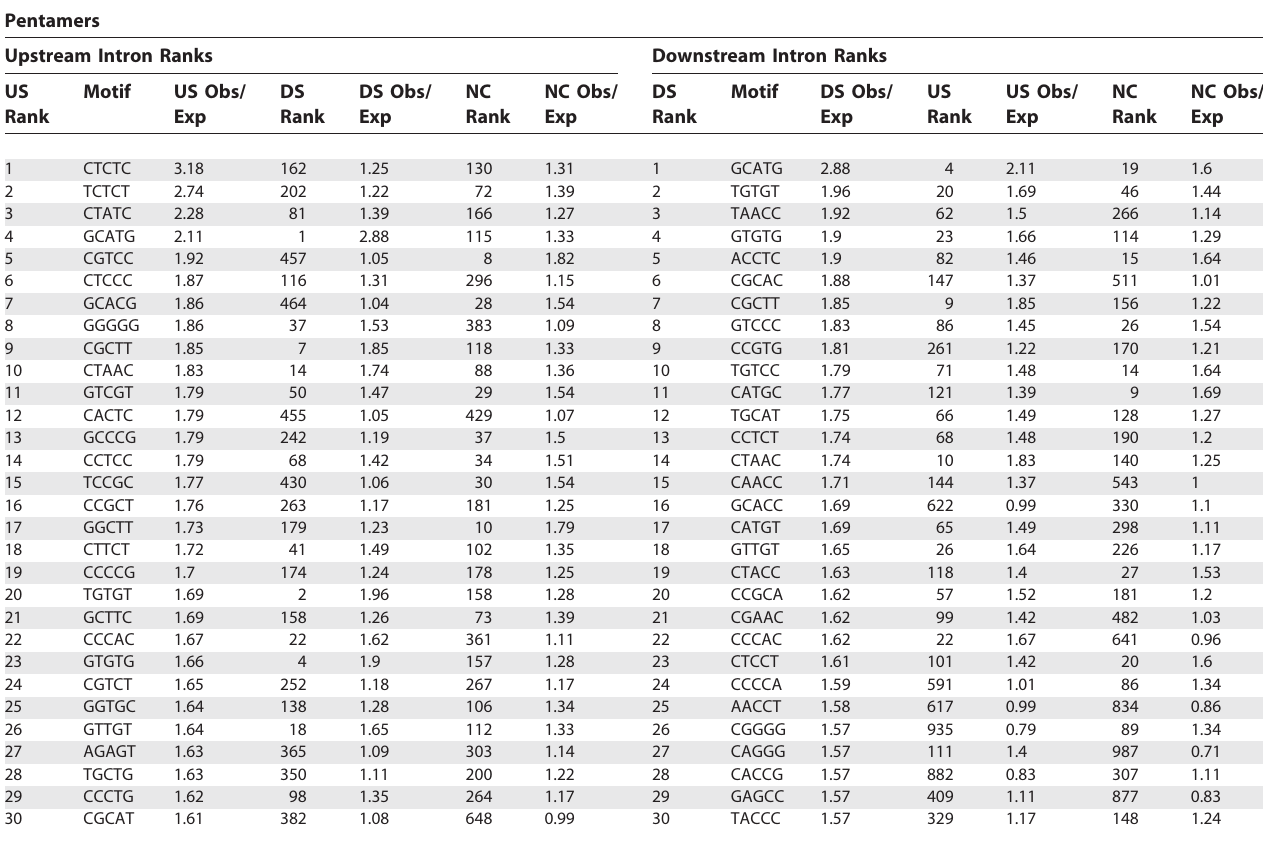
Table 3. Comparison of the Occurrence of Pentamer Motifs in Introns Upstream versus Downstream of Alternative Cassette Exons